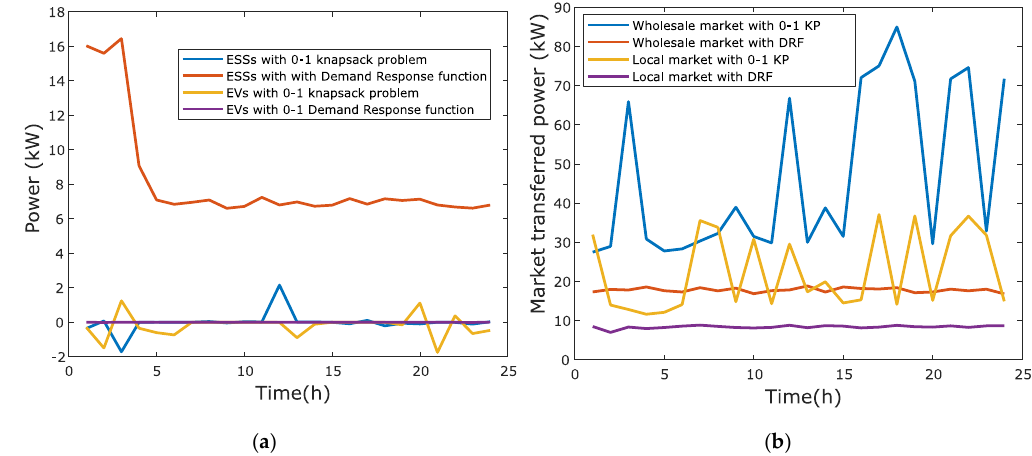
Figure 13. Power exchanged with 0-1 KP and DRF. ( a ) EVs and ESSs scheduling for day-ahead; ( b ) electricity markets scheduling for day-ahead.